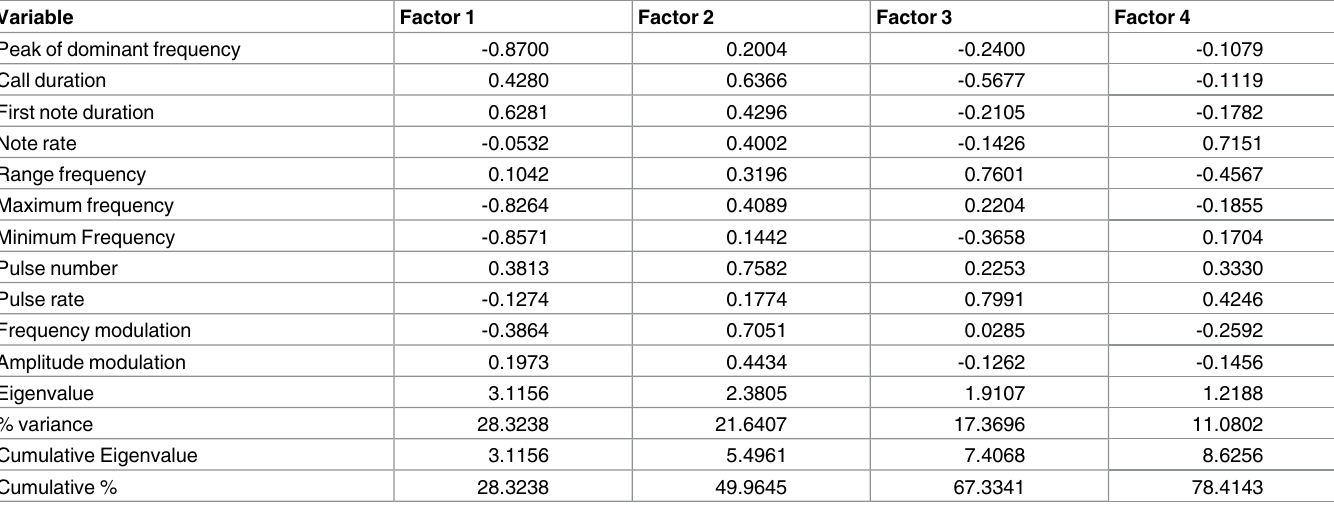
Table 2. Results of a principal component analysis of the general structure of acoustic variables in Dendropsophus elegans .